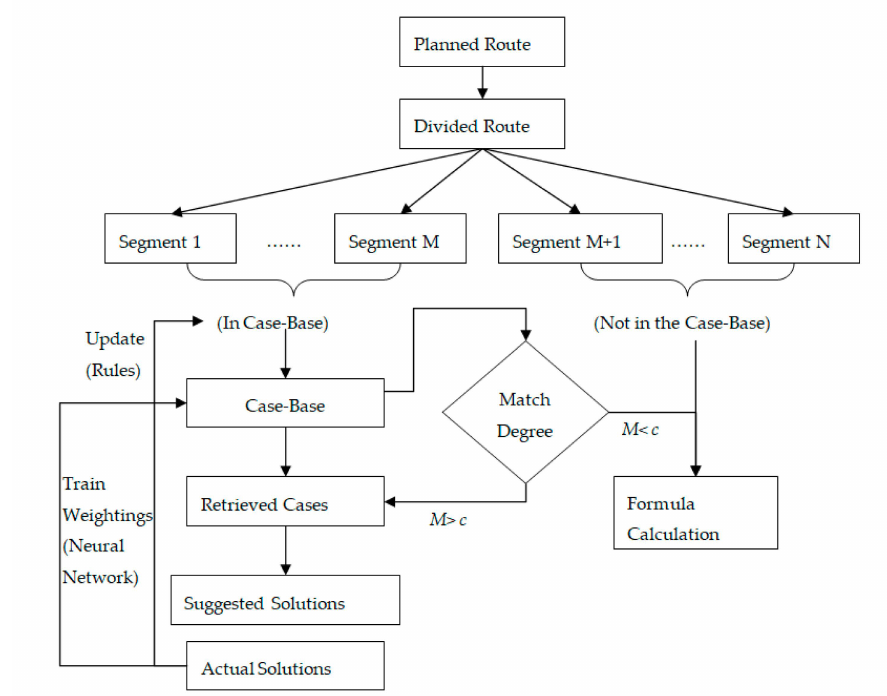
Figure 2. The sub case-based reasoning (CBR) system architecture.